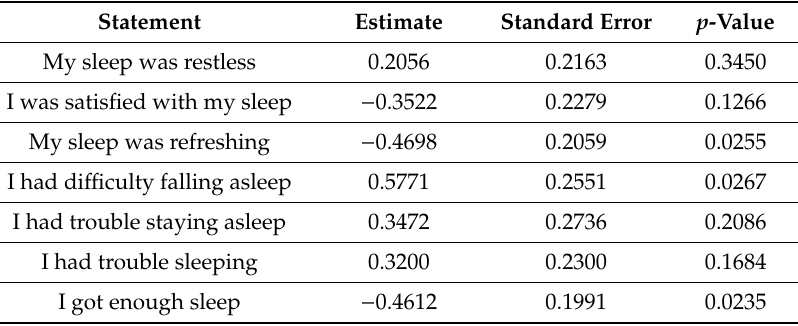
Table 8. Coe ffi cient estimate for airport region based on linear mixed models adjusted for age, sex, and BMI for the listed sleep questions. Response categories were always (5), often (4), sometimes (3), rarely (2), and never